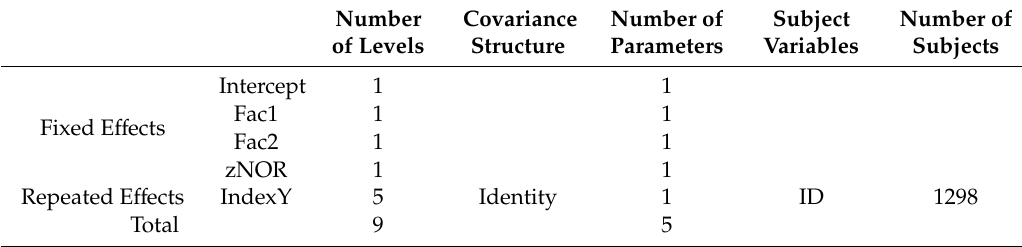
Table 7. Model dimension a .